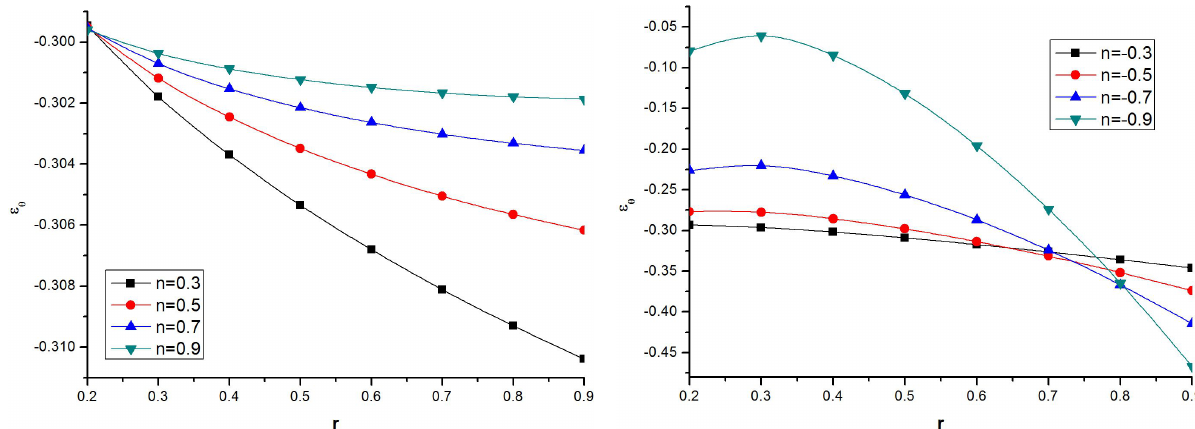
Figure 7: Variation in circumferential strain against radial coordinate for different values of n